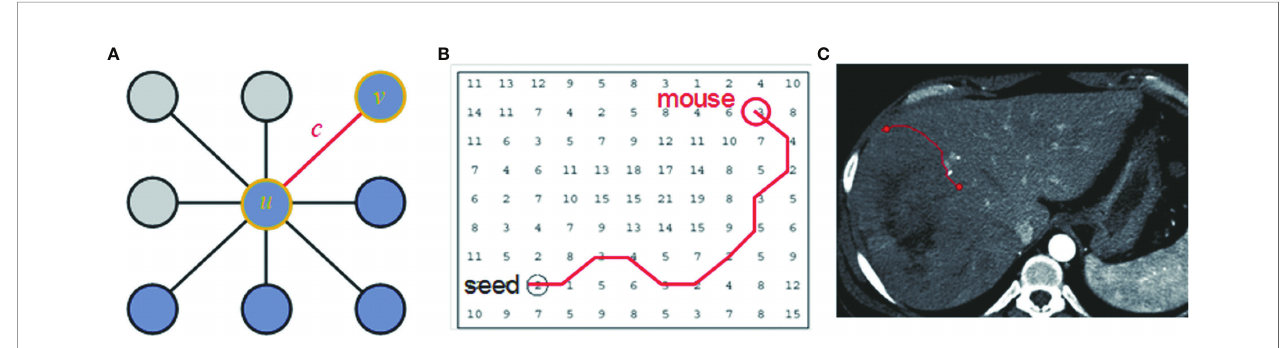
FIGURE 2 | The local boundary is de fi ned as the optimal path with the minimum cost between two corresponding nodes in the graph. (A) An image can be represented as a 2D weighted bi-directed graph, in which one node corresponds to a pixel in the image. Each node (pixel) has 8 links (edge) connecting to its neighborhood pixels. Both node ( u or v ) and link (C) have a related cost. (B) A contour on a 2D transversal image is de fi ned as the optimal path with the minimum cost between two corresponding nodes in the graph, which can be searched by dynamic-programming methods such as Dijkstra ’ s algorithm. (C) A contour in the image corresponds to the optimal path in (B)